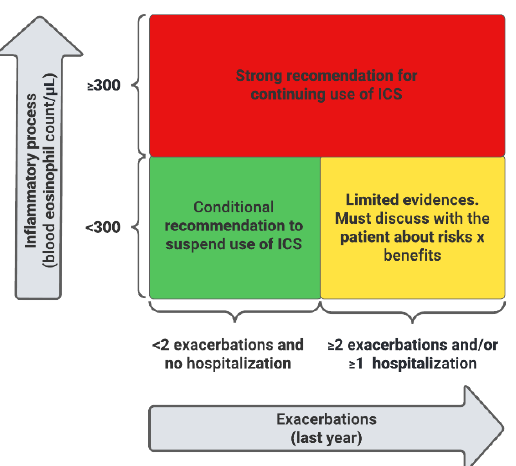
Figure 2. ICS treatment in COPD patients. Red zone: ICS use is recommended; yellow zone: controversial use of ICS; green zone: consider withdrawing ICS. ICS: inhaled corticosteroids. Adapted from Chalmers JD et al., 2020 [18] .